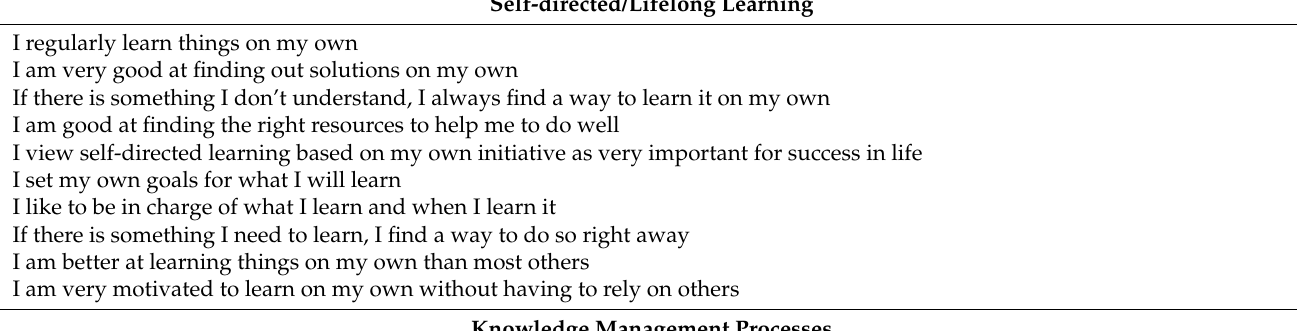
Table A2. Cont. Self-directed/Lifelong